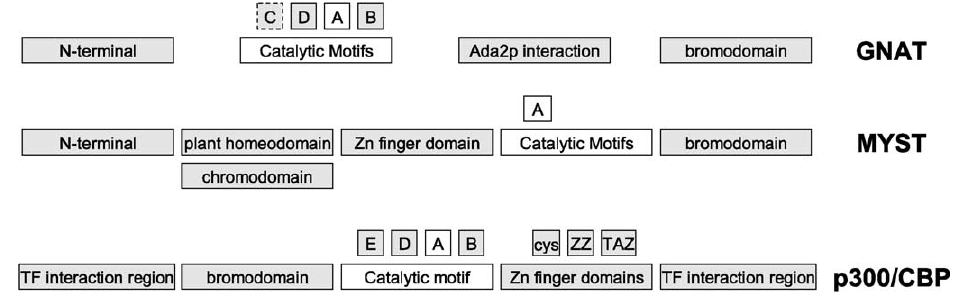
Fig. 3. Functional domains of HATs. For the function of the different domains see text (source: